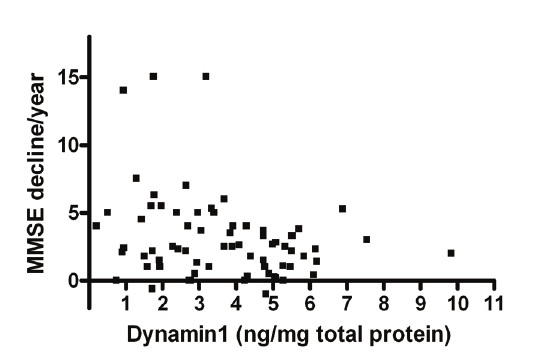
Figure 4. Correlates between Dynamin1 level in BA9 and rate of cognitive decline. Correlation between values of Dynamin1 level in BA9 in dementia cases and the MMSE decline per